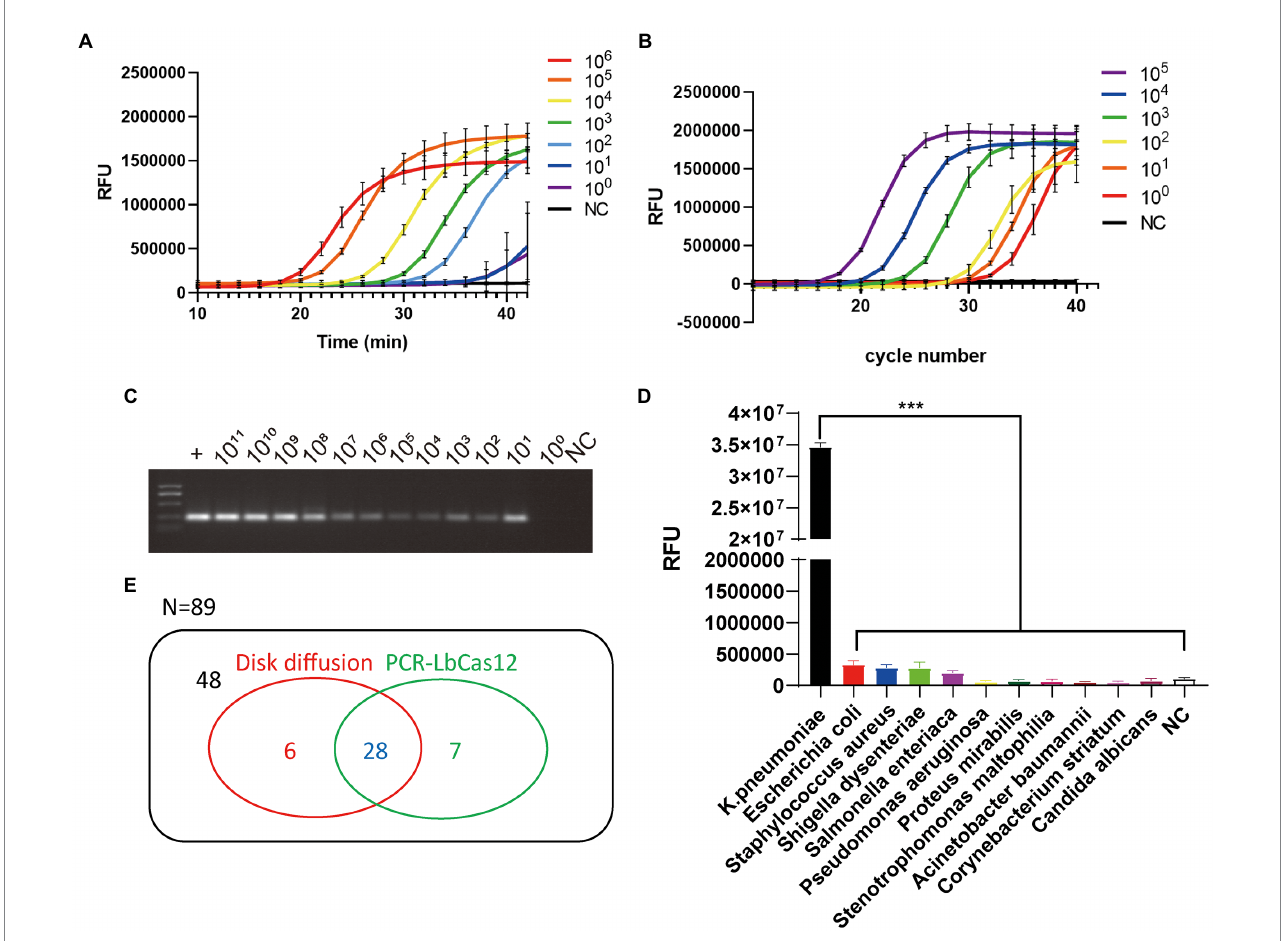
FIGURE 2 (A) The RFU signal generated by the PCR-LbCas12a system detecting the serially diluted standard YP_005224572.1 DNA. (B) The qPCR results of serial diluted standard DNA samples. (C) 1% agarose gel electrophoresis of the PCR product from serial diluted standard DNA samples. (D) Different pathogens was detected by PCR-Cas12a system. Only Klebsiella pneumoniae was successfully detected. Data are mean ± s. d. of n = 3 biological independent experiments. (E) Venn diagram of results of testing 89 sputum samples in disk diffusion assay and PCR-LbCas12a